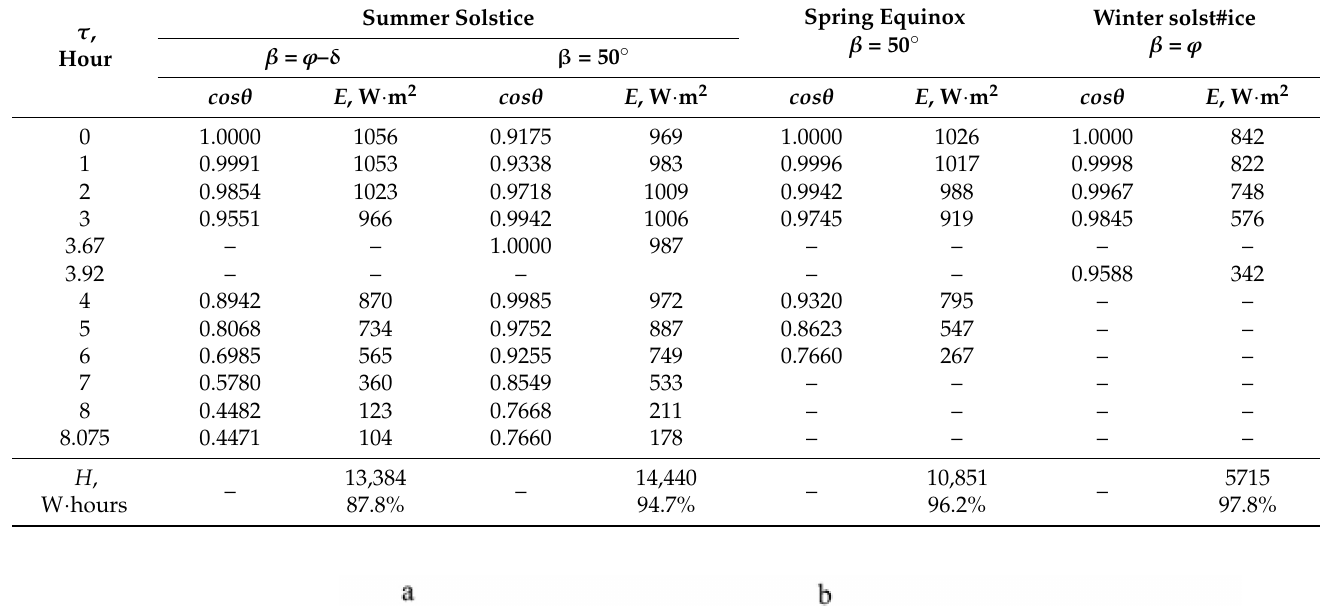
Table 6. Orientation and exposure efficiency of the tracking surface while rotating around the vertical axis (own research).